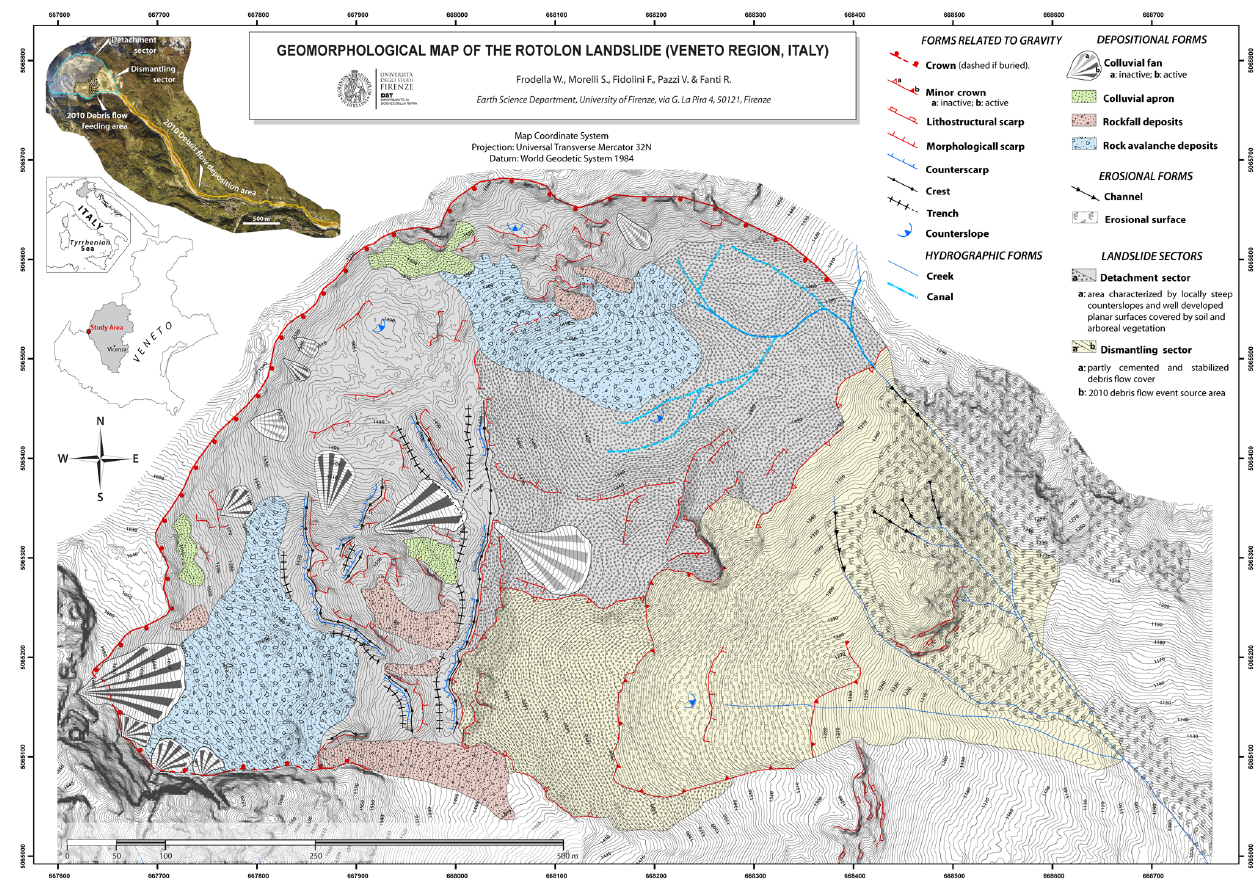
Figure 3. Geomorphological map of the Rotolon Landslide (modified after Frodella et al., 2014).